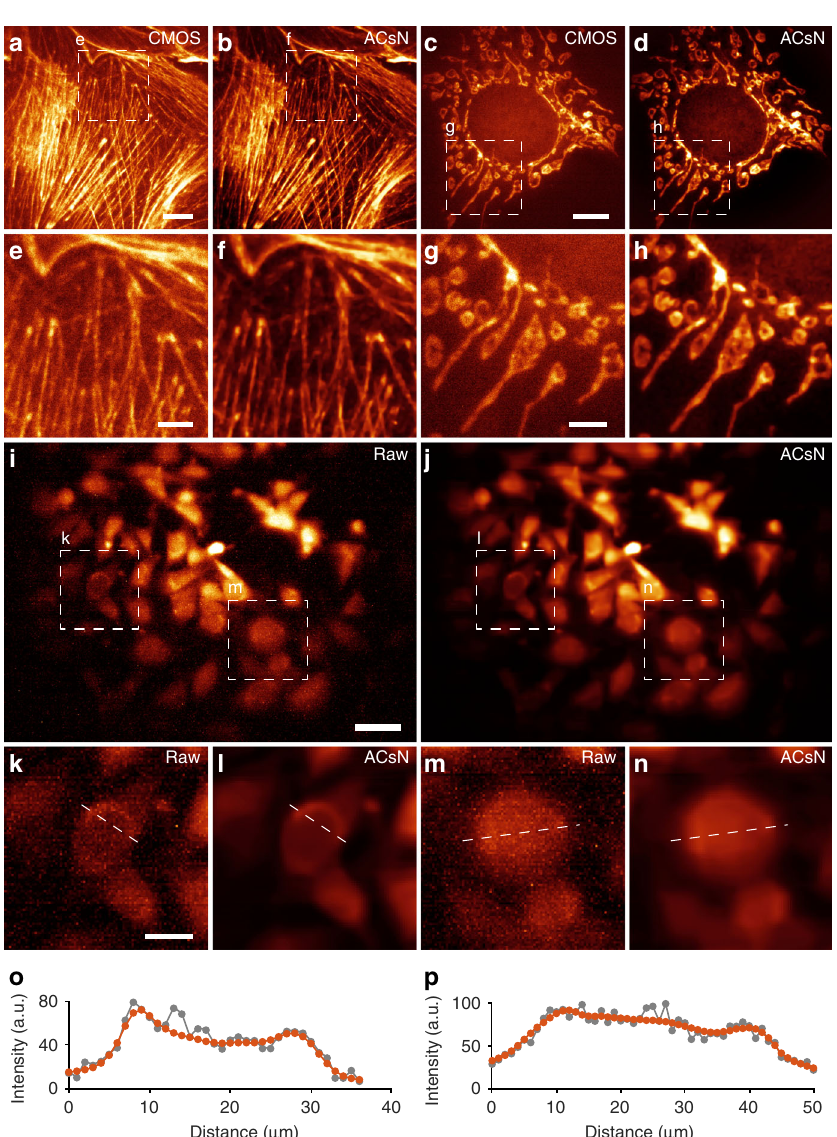
Fig. 5 ACsN improves fl uorescence microscopy with low-cost CMOS cameras. a TIRF image of F-actin in a fi xed BPAE cell, taken at a frame rate of 38 Hz (exposure time: 26 ms). b The same image in a after ACsN denoising. c Epi- fl uorescence imaging of mitochondria in a fi xed bovine pulmonary artery endothelial (BPAE) cell, taken at a frame rate of 38 Hz (exposure time: 26 ms). d The same image in c after ACsN denoising. e – h Zoomed-in images corresponding to the boxed regions in a – d , showing the improvement of image quality after ACsN denoising. In particular, such improvement is comparable to the images taken with sCMOS sensors, as shown in Supplementary Figs. 5 and 6. i , j Images of GFP-stained calcein in live Adipocytes (lipocytes) taken with low-cost CMOS for miniaturized microscopy before ( i ) and after ( j ) ACsN denoising. The data were taken by immersing a miniscope in live-cell culture. k – n Zoomed-in images of the corresponding boxed regions in i and j . o , p Plots of the cross-sectional intensity pro fi les of cellular structures before (gray) and after (red) ACsN denoising along the dashed lines in k , l and m , n , respectively. Scale bars: 10 μ m ( a , c ), 4 μ m ( e , g ), 50 μ m ( i ), 20 μ m ( k